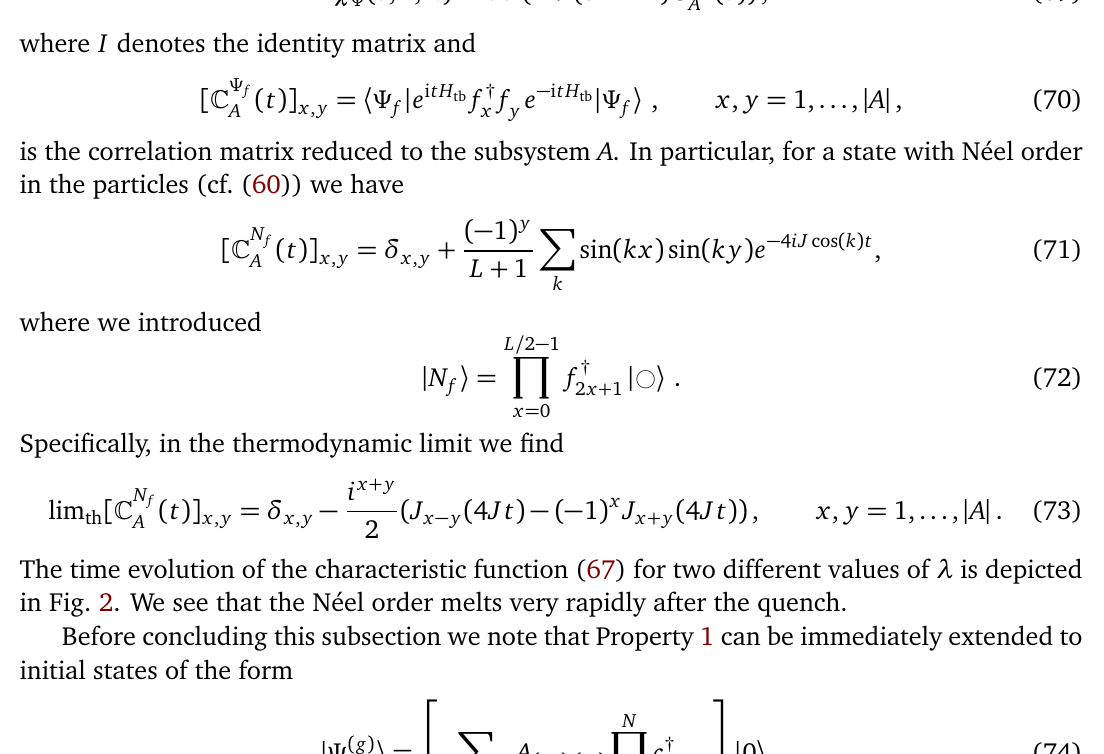
Figure 1: Time evolution of one-point function (left) and connected two-point func- tion (right) of the total density operator n after a quench from an initial state with x Néel order in the particles (cf. (60)) in the thermodynamic limit (the insets report the long time behaviour). The one-point function relaxes to 1 / 2 in the infinite-time limit while the connected two-point function goes to δ . Note that at times J t = 2 x / 4 x ,0 and J t = ( x + y ) / 4 the correlations begin to be affected by the boundary (the maxi- = 4 J mal velocity for the propagation of correlations is v max